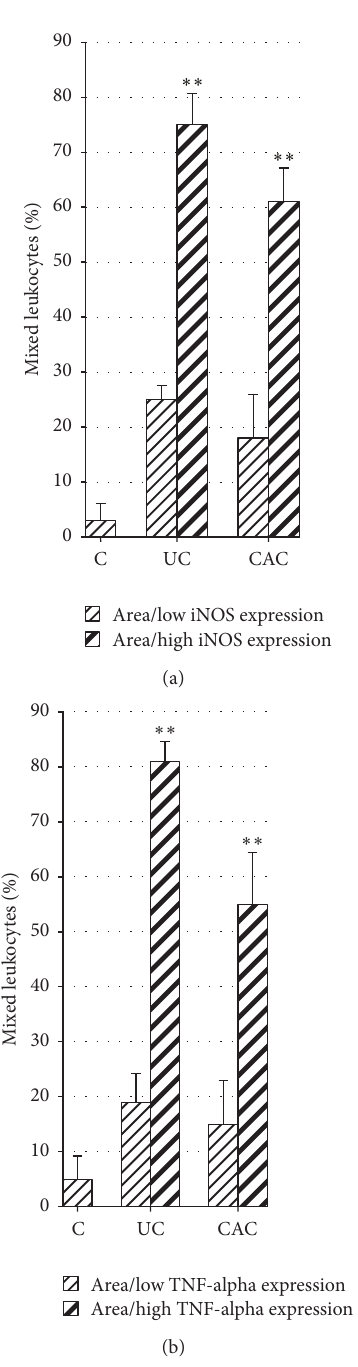
Figure 5: Percentage of mixed leukocytes in areas with high or low expression of iNOS and TNF- 𝛼 . Mixed leukocytes (inflammatory cell infiltrate) were counted in 4 wells nonoverlapping in areas of iNOS/TNF- 𝛼 overexpression and areas with low expression. High density of mixed leukocytes was observed in areas of iNOS and TNF- 𝛼 overexpression as compared with areas of low iNOS/TNF- 𝛼 expression in colonic mucosa of UC and CAC patients ( ∗∗ 𝑃 < 0.01 ).